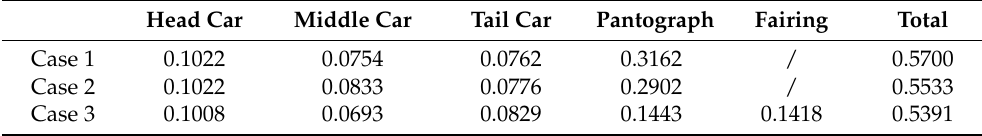
Table 4. Computed drag coefficients of three